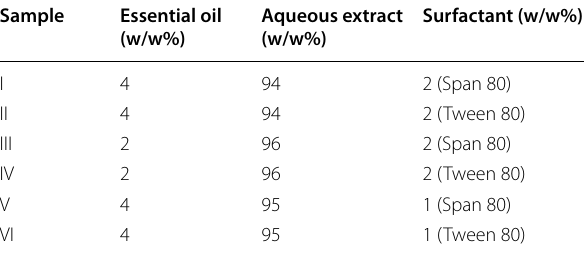
Table 1 The percentage of NE components